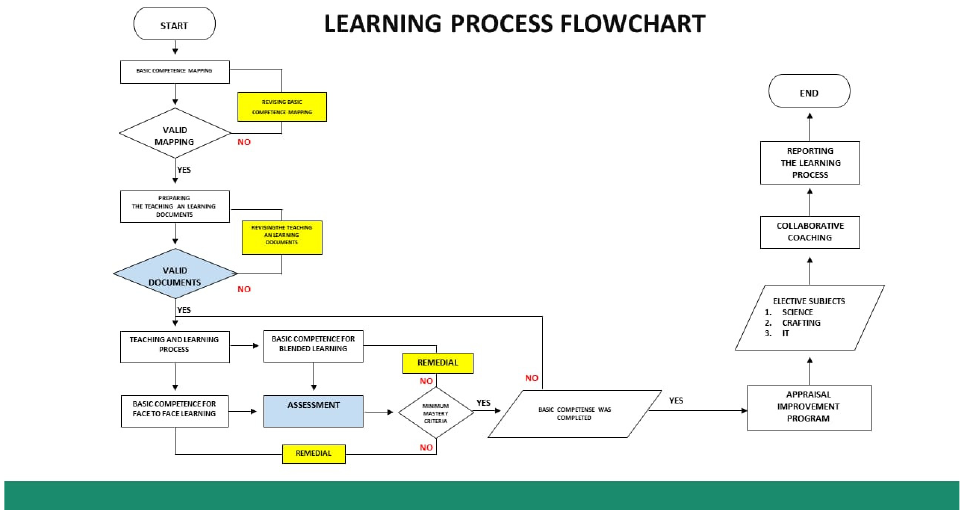
Figure 5. Learning process flowchart.